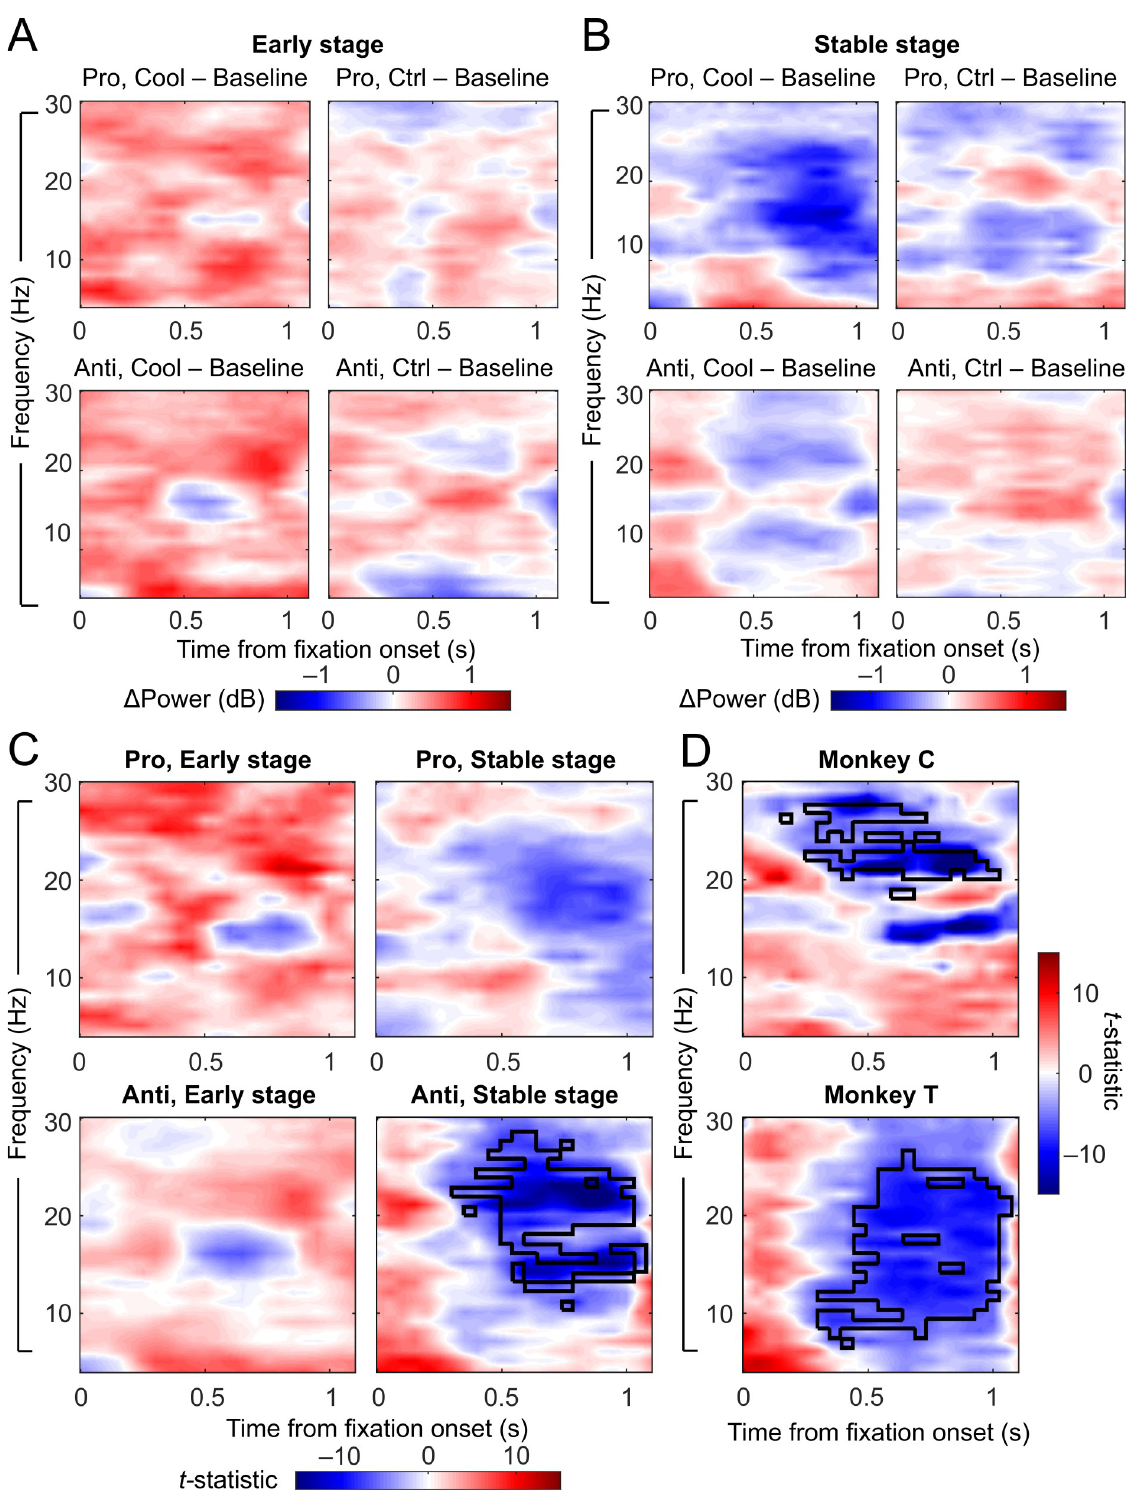
Fig 8. ACC deactivation reduced the C-E difference in dlPFC beta-band LFP power in the fixation periods of antisaccade trials at the Stable stage. (A) Change in C-E difference in LFP powers from the baseline to the cooling epochs (left panels) or the control epochs (right panels) at the Early stage. Left panels demonstrate the effect of both cooling and epoch, while right panels illustrate the effect of epoch only. (B) Change in C-E difference from the baseline to the cooling epochs (left panels) or the control epochs (right panels) at the Stable stage.